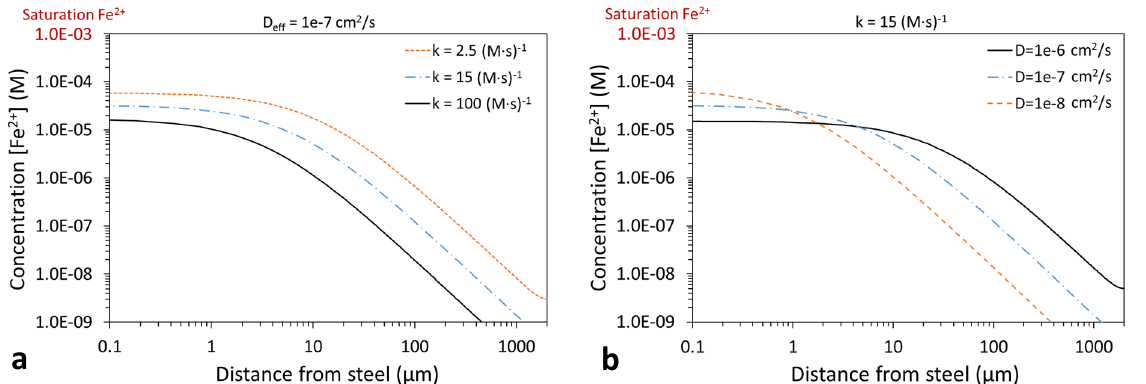
Figure 4. Concentration of dissolved Fe 2+ in case different oxidation kinetic constants are used at fixed D eff (1∙10 ‐7 cm 2 /s, intermediate diffusion coefficient) (a) and if different effective diffusion coefficients are used at fixed k (15 M ‐1 ∙s ‐1 , intermediate oxidation rate) (b) as a function of the distance from the steel surface (at t=50 h). As expected, the concentration of Fe 2+ at the steel surface increases if the Fe 2+ sinks, namely Fe 2+ oxidation and Fe 2+ diffusion, are slow. Nevertheless, in all here studied combinations, the Fe 2+ concentration at the steel surface is always lower than the saturation threshold, thus, no Fe 2+ precipitation is expected to occur.